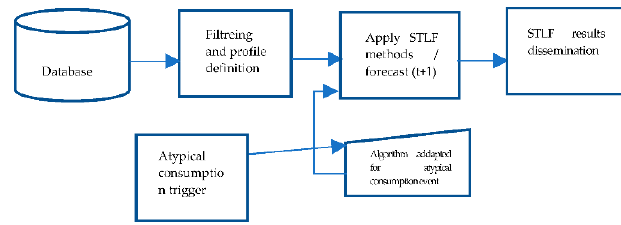
Figure 1. Flowchart of STLF in atypical consumption behavior.